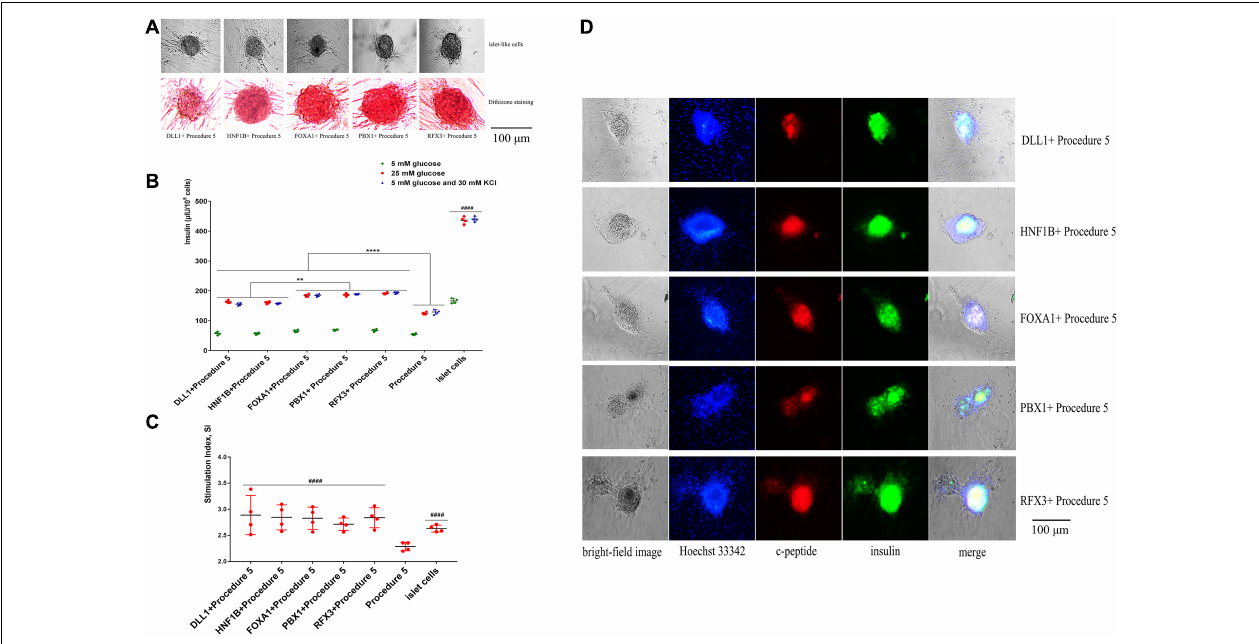
FIGURE 6 | Functional verification of the Foxa1 , Hnf1b , Dll1 , Pbx1 , and Rfx3 . (A) The cells agglomerated into a spherical shape, with obvious islet-like cells. The cells were stained with dithizone, and the cells could be dyed red. (B) After the stimulation of low glucose (5 mM), high glucose (25 mM), 5 mM glucose, and 30 mM KCl, the secretion of insulin in procedure 5 was significantly lower than that of genes overexpression groups (**** p < 0.0001). The secretion of insulin in FOXA1 + Procedure 5, PBX1 + Procedure 5, and RFX3 + Procedure 5 was highest (** p < 0.01), but they were all lower than the mature islet cells group (#### p < 0.0001) ( n = 4). (C) The glucose stimulation index of genes overexpression is greater than 2.5, and higher than procedure 5 (#### p < 0.0001) ( n = 4). (D) Immunofluorescence staining of insulin and c-peptide showed that the cells were insulin and c-peptide positive. Green was insulin, red was c-peptide, and Hoechst 33342 made the nucleus